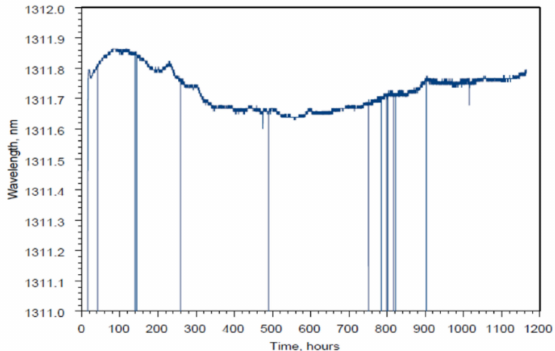
Figure 2. Bragg wavelength drift of a RFBG at 1000 ◦ C (reproduced from